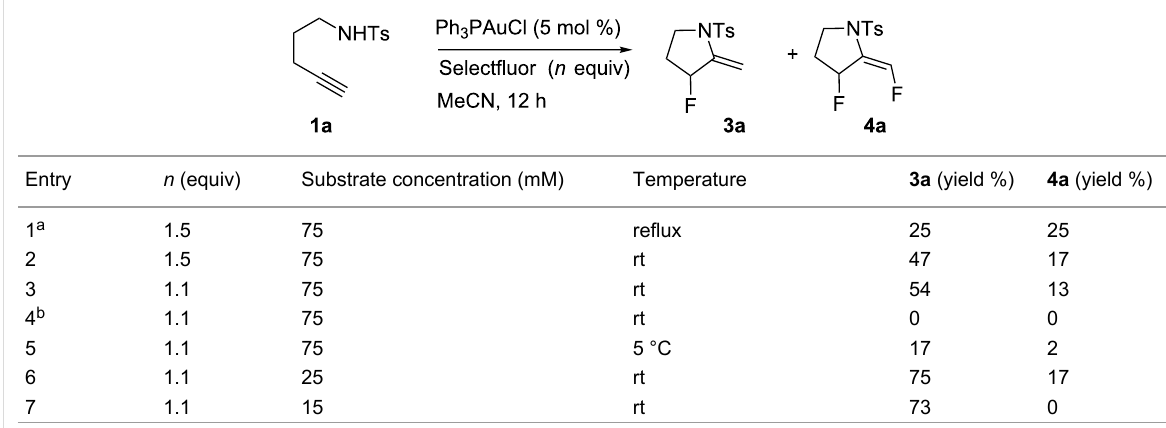
Table 2: Effects of reaction conditions on the Au(I)-catalyzed cyclization of 1a in the presence of Selectfluor.